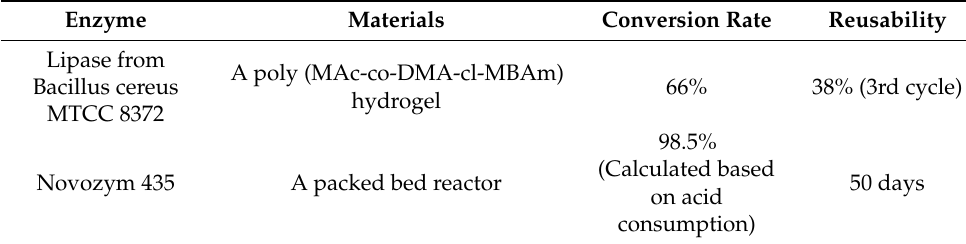
Table 3. Isopropyl myristate